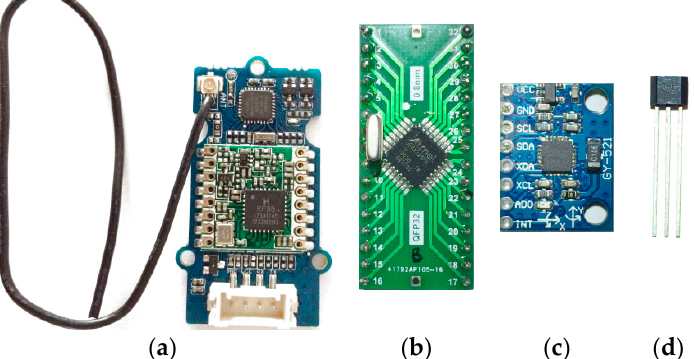
Figure 2. Main components of sensing module: ( a ) Grove LoRa Radio Transceiver 433MHz; ( b ) AVR